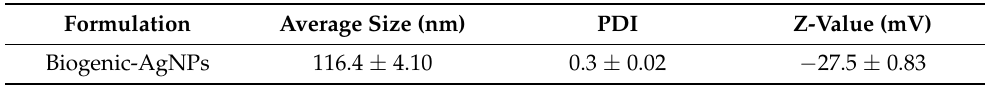
Table 1. DLS measures of